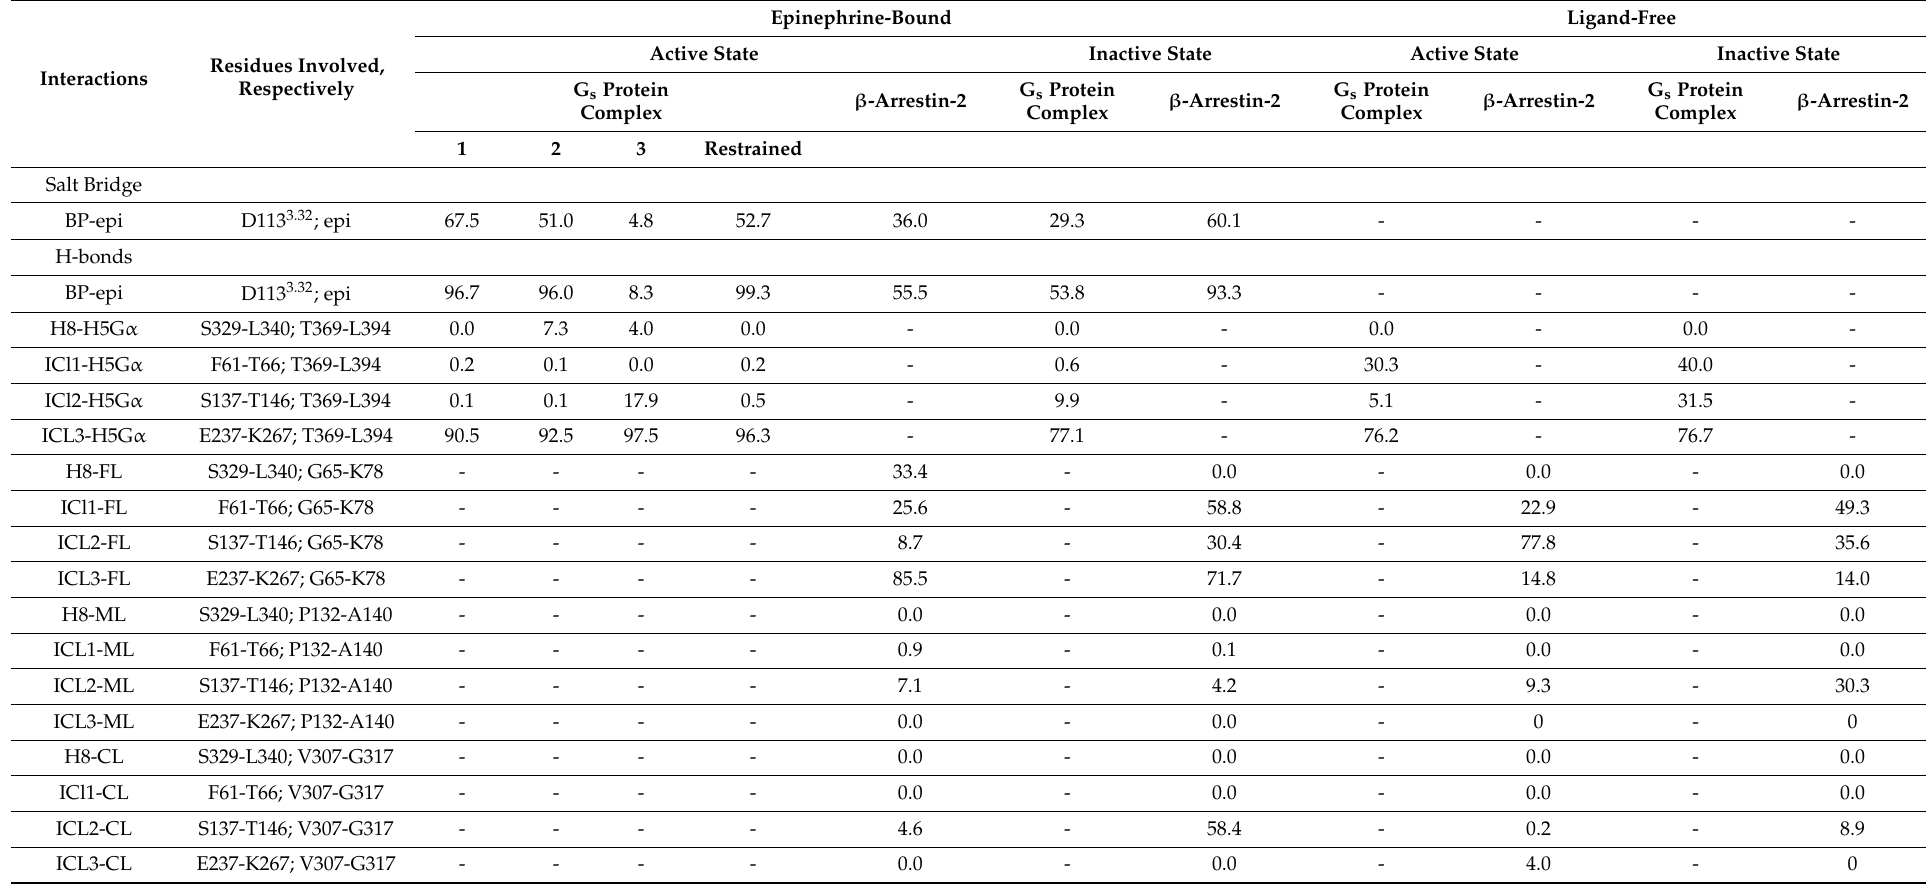
Table 3. Frequency of intermolecular salt bridges and H-bonds expressed as percentages of the total conformational ensemble, generated by MD simulations.